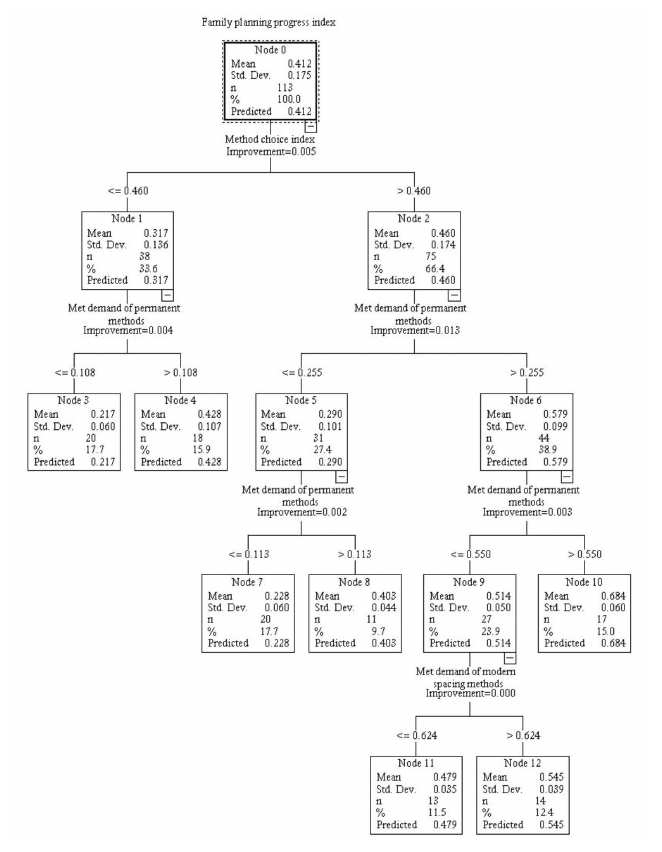
Figure 2: The Classification